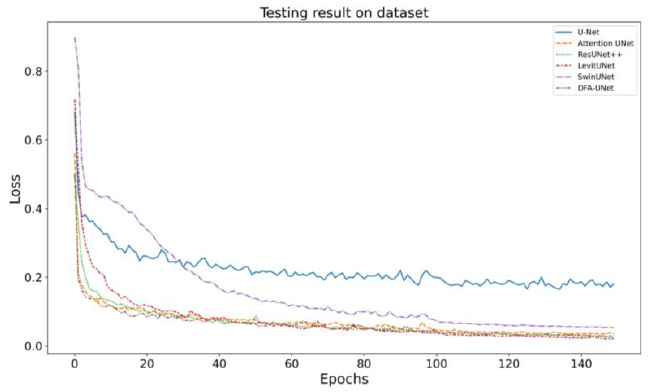
Figure 5. Training loss on different models.